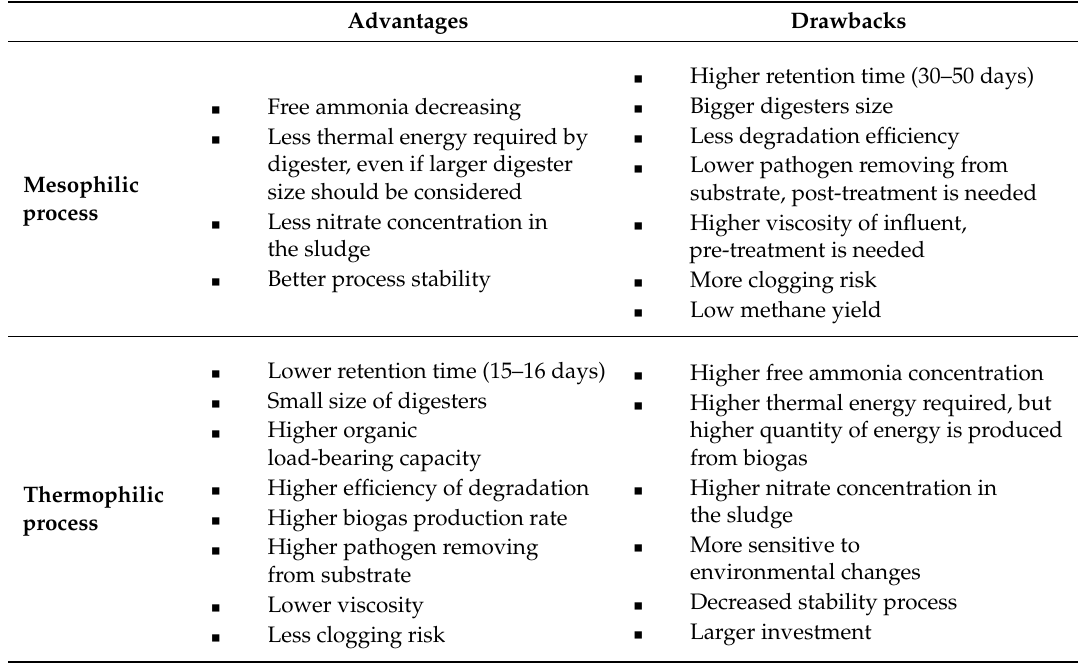
Table 1. Mesophilic versus thermophilic process